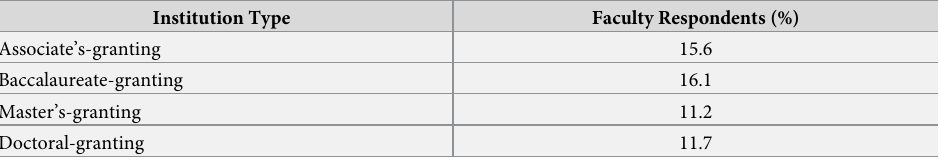
Table 5. Placement of faculty with terminal degrees earned in 2010–2016 by institution type.